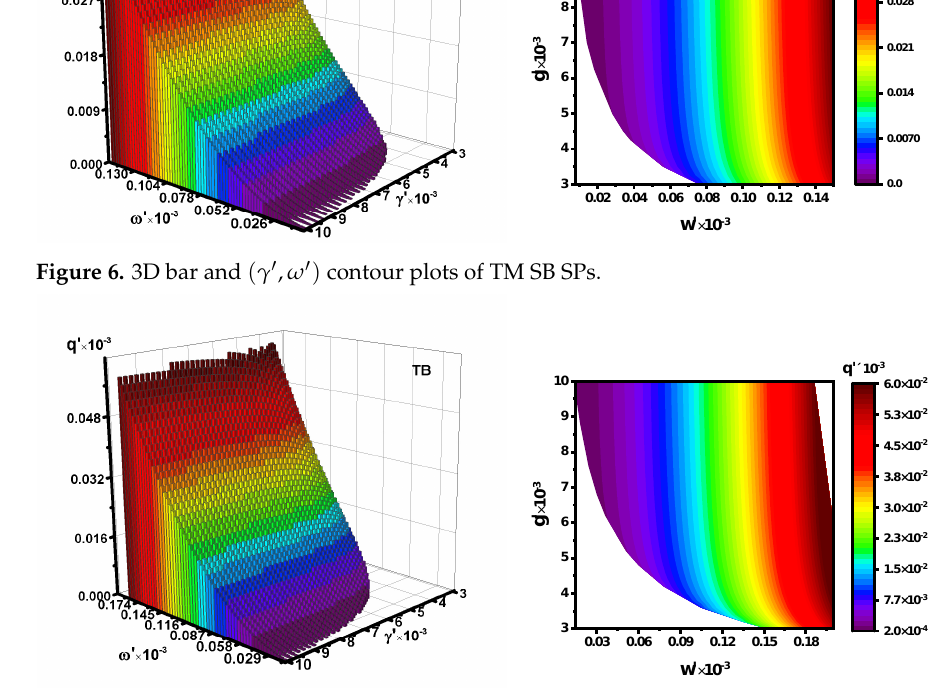
Figure 7. 3D bar and ( γ (cid:48) , ω (cid:48) ) contour plots of TM TB SPs.